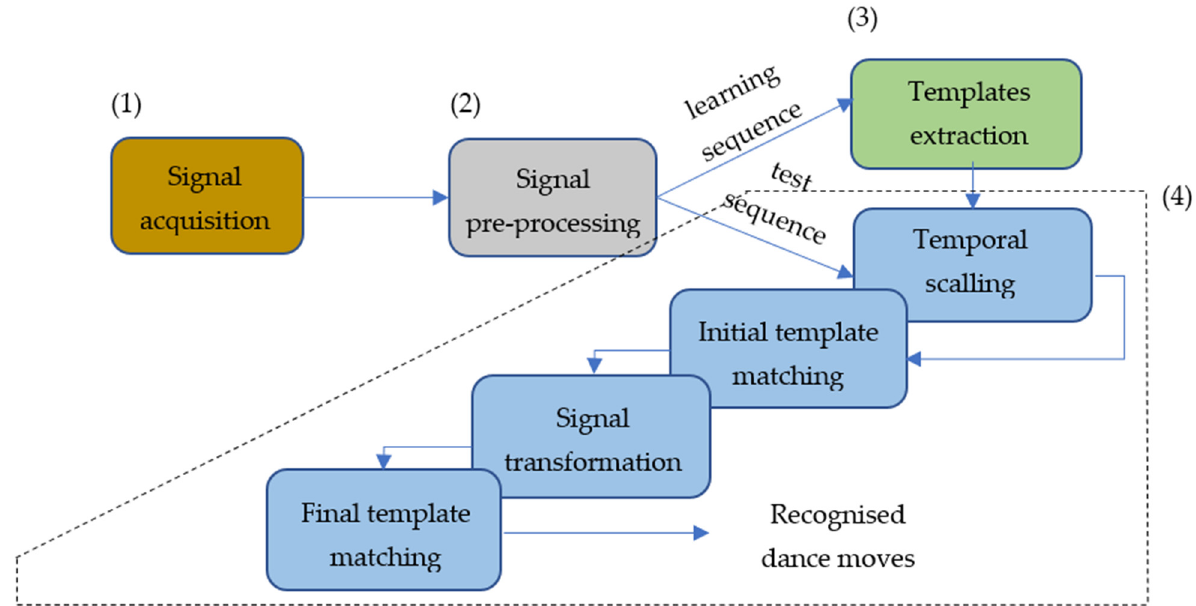
Figure 1. Dance move recognition processing workflow.